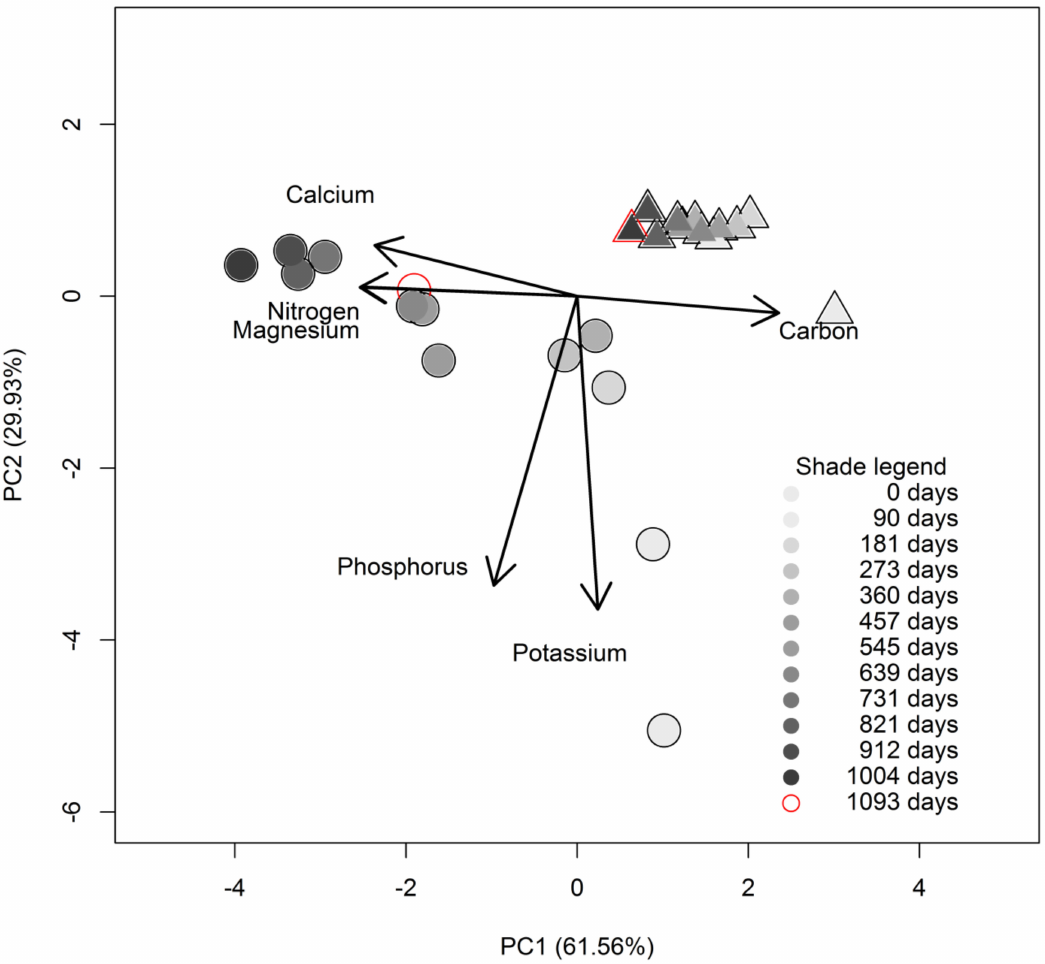
Figure 3. Principal components analysis (PCA) of the chemical contents of twig (circle symbol) and small root (triangle symbol) litter from Parashorea chinensis Wang Hsie through the decomposition process. The degree of shading indicates how long the materials have been incubated. The lightest grey represents the starting point (0 days), the darkest grey the second last point (1004 days), and the empty symbol the last collection (after 1093 days incubation). Materials were incubated in a common litter-bed on the rain forest floor at Mengla county, Xishuangbanna, China. Note that the contribution of magnesium and nitrogen in explaining the variation of nutrients concentration during decomposition is the same so their respective arrows are overlapping. Also due to overlapping, we use red color to show the last collection